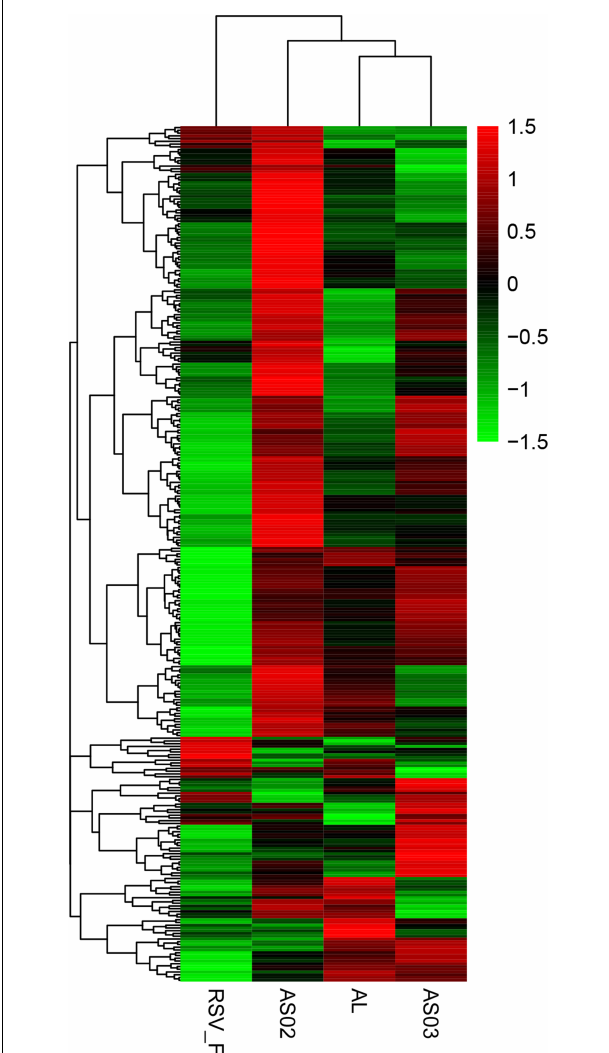
FIGURE 7 | Hierarchically clustered heat maps showing differentially expressed immune-related genes between the adjuvant and adjuvant-free groups. Rows correspond to different genes and columns represent the different samples. The tree above the heat map shows the hierarchical clustering of the samples. The color scale shown in the map illustrate the log10 FPKM. Red and green colors represent high and low expression, respectively. For the description of the genes differentially expressed, please refer to Supplementary Table S1 (Hierarchically clustered heat maps) and Supplementary Table S2 (Immune-related Hierarchically clustered heat